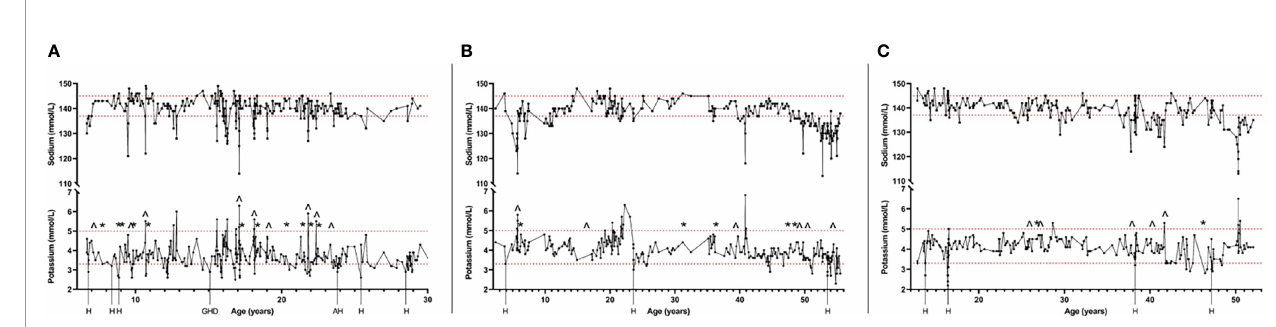
FIGURE 2 | Timelines of three patients with APECED and tendency for hypokalemia showing the fl uctuating serum concentrations of sodium and potassium during follow-up of the patients. Also, hospitalizations (H) and other stressful periods of disease course at the time of hypokalemia are shown. Changes of fl udrocortisone replacement dosage of 50% or more are also shown (^, increase of the dosage; *, decrease of the dosage). Figure shows one patient selected by different criteria for tendency of hypokalemia: Patient (A) had been previously detected with hypokalemia combined with hypertension; Patient (B) was using daily potassium substitution at the time of study visit; Patient (C) had current potassium level lower than 3.0 mmol/L during the study visit. Dashed lines show the reference range of potassium (3.3-5.0 mmol/L) and sodium (137-145 mmol/L). H, Hospital care; GHD, Growth hormone de fi ciency detected; AH, Activation of